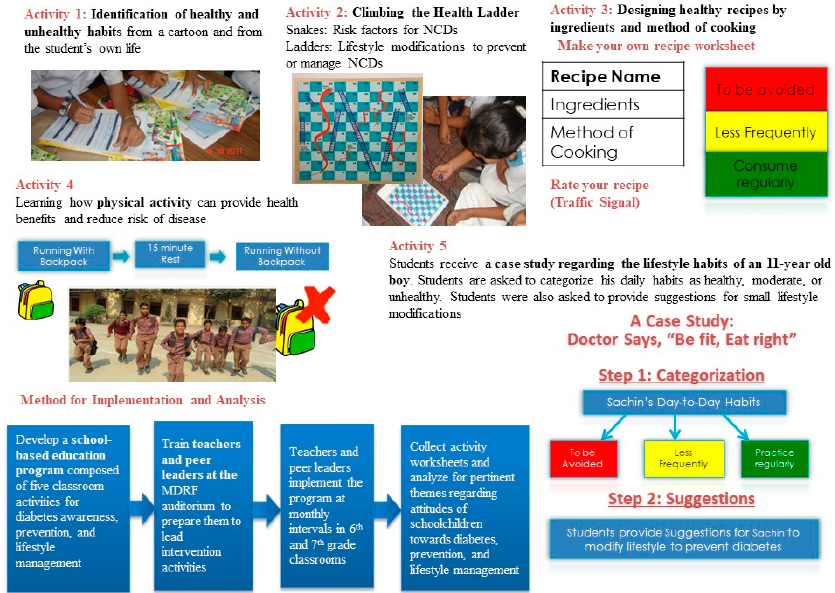
Figure 1. Description of classroom intervention activities, conceptualized, designed and developed into an activity manual by Health ‐ Related Information Dissemination Amongst Youth